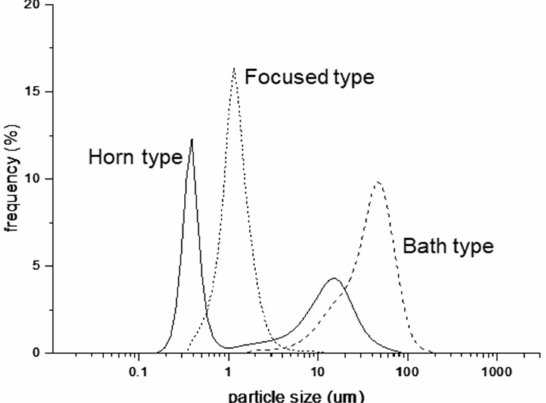
Figure 2. Size distribution of oil particles obtained used horn, bath, and focused